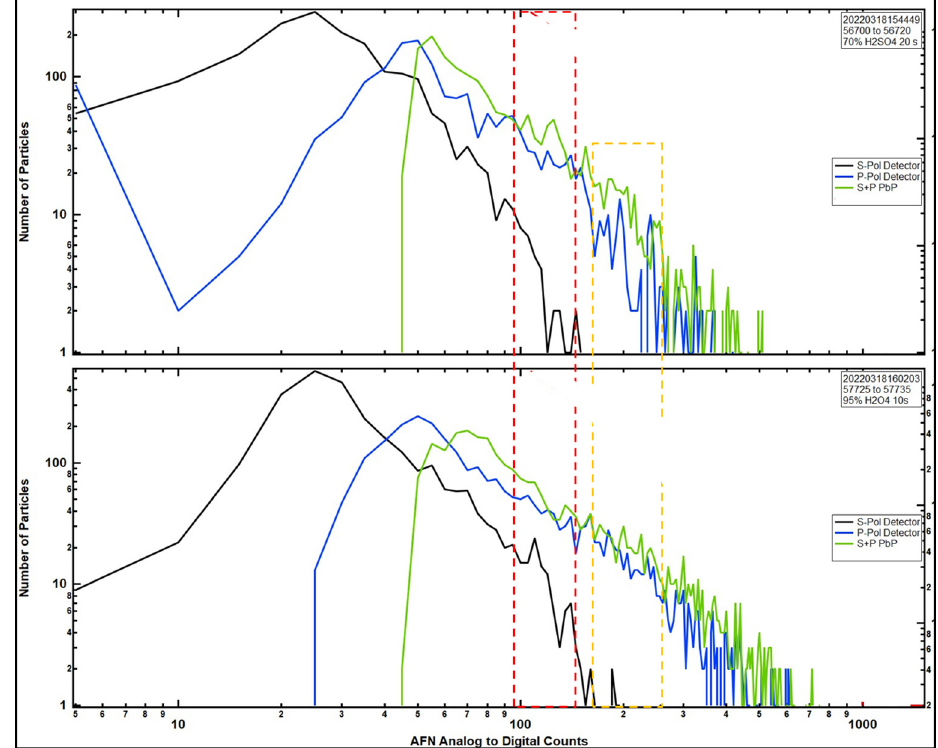
Figure 7. The number of particles, detected by the AFN, drawn as a function of the polarized light scattering intensity, is shown to illustrate how the Mie oscillations can be observed in these frequency distributions. The red and orange boxes highlight where the peaks and valleys have shifted due to difference in the mixing ratios.